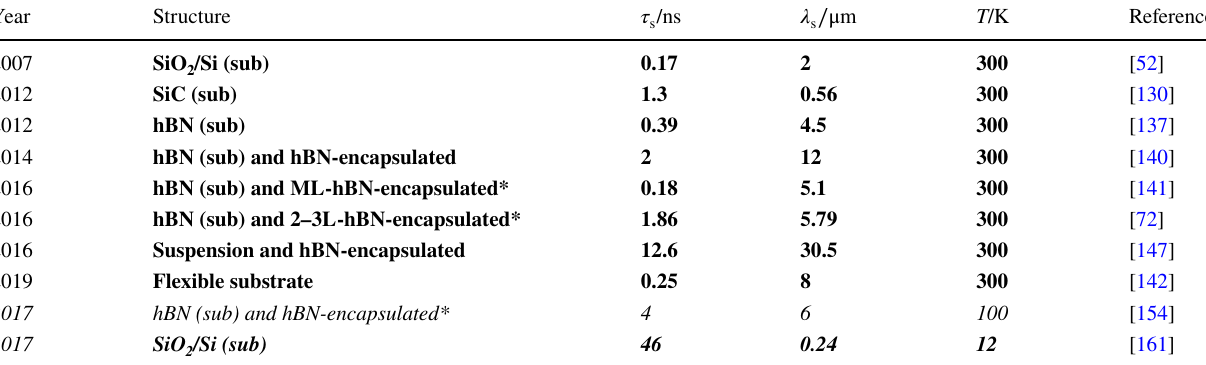
Bold, graphene; italic, BP; bold–italics, MoS 2 . It should be noted that the below statistics are incomplete, just representative results. *means that the encapsulated hBN is also a tunnel